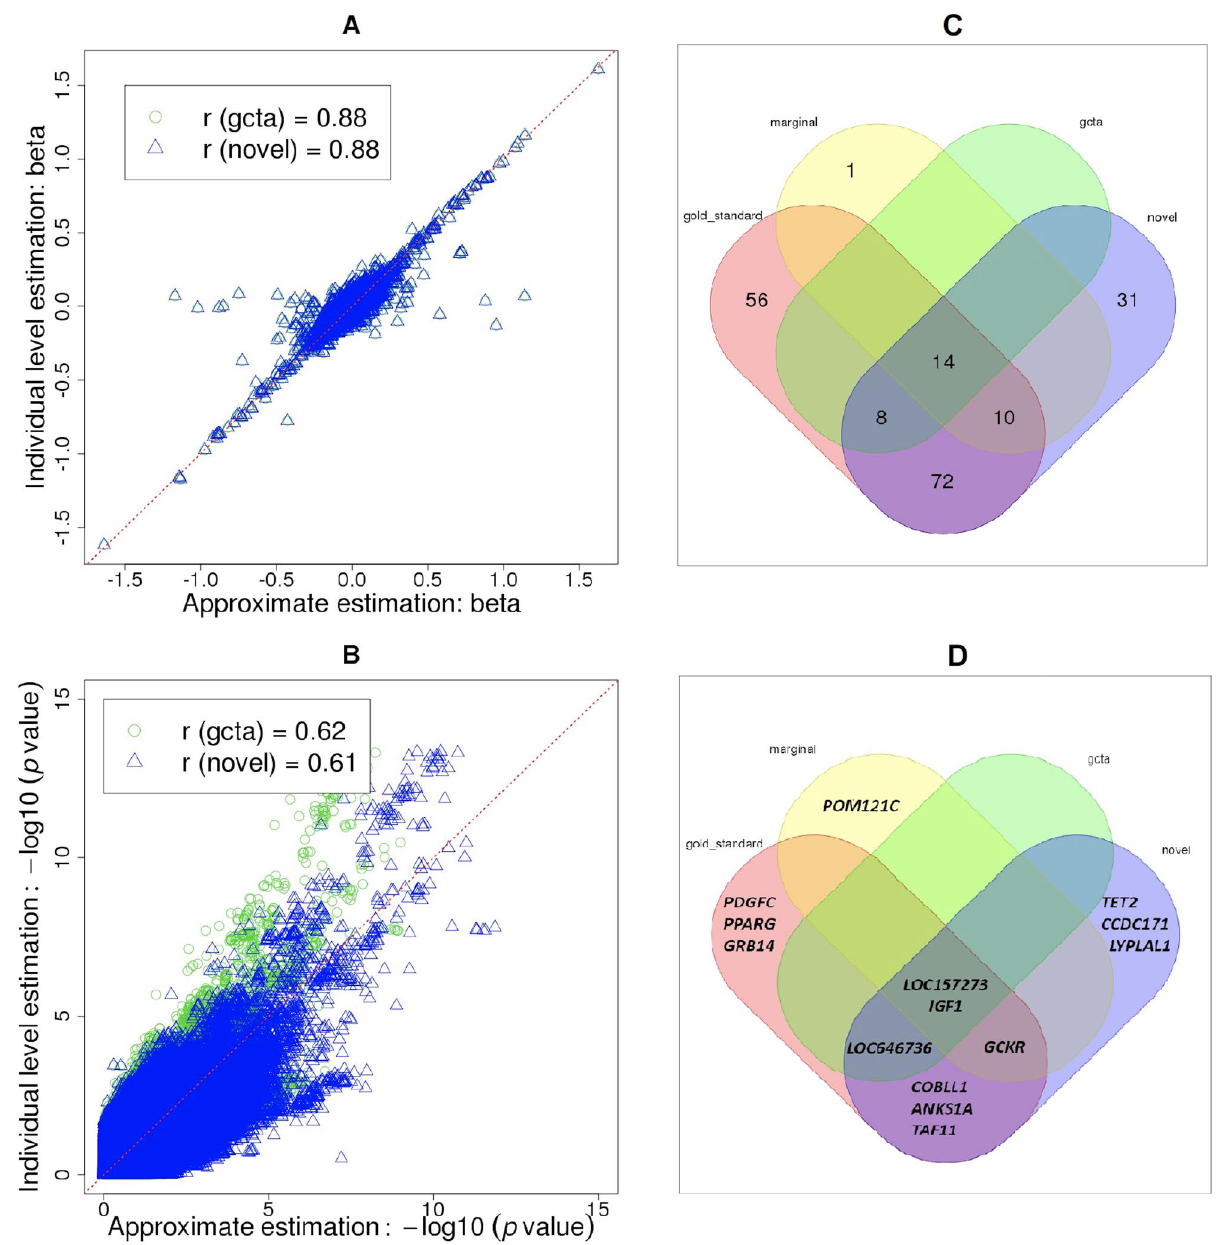
Figure 4. Estimated effect sizes ( A ), − log10 (p-values) ( B ), number of genome-wide significant variants ( C ), and genome-wide significant genes ( D ) for existing GWAS meta-analysis for fasting insulin adjusted for body mass index. Individual level data results provide the gold standard for estimation and is denoted as “gold_standard” in the Venn diagram, “marginal” results are the fasting insulin GWAS results without BMI adjustment, and “gcta” results are obtained using multi-trait-based conditional and joint analysis (mtCOJO) implemented in GCTA 1.9 (GCTA mtCOJO), with the Framingham Heart Study (FHS) unrelated subset of individuals used for the LD reference panel. “Novel” results are obtained from our novel method with phenotype data from FHS to estimate the relationship between traits. Genome-wide significant level equals to the 0.05/total number of variants (0.05/2,407,460 = 2.08 × 10 –8 ). Genome-wide significant genes are the genes closest to the significant